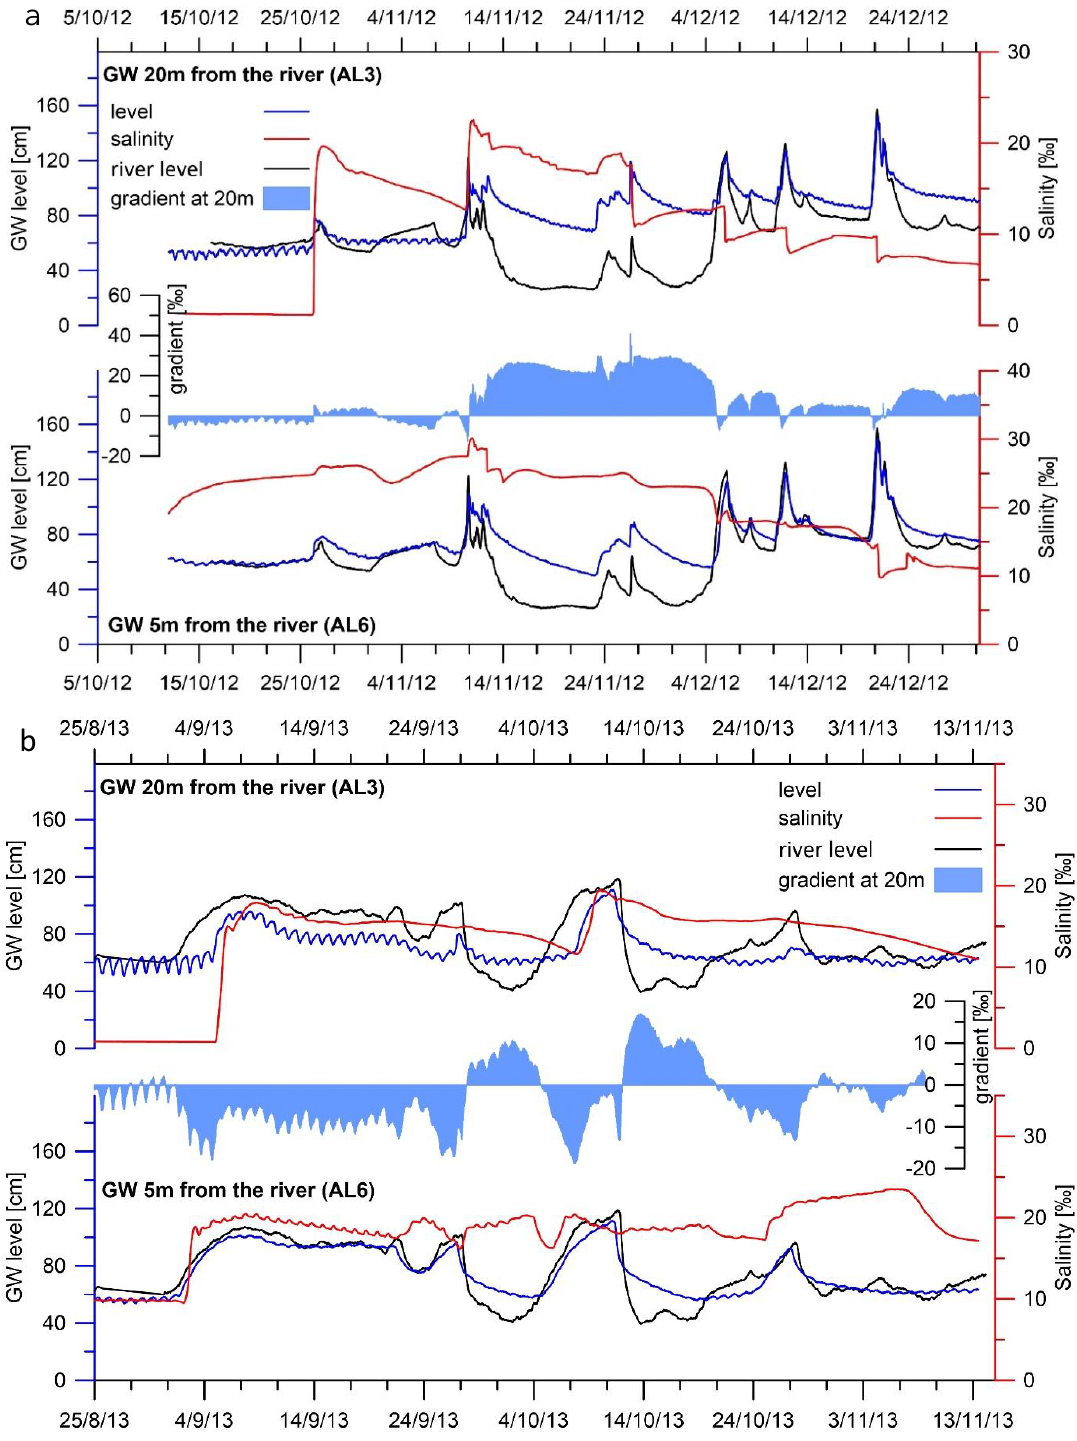
Figure 12. Groundwater level and salinity, and aquifer–river gradient during ( a ) fall 2012 and ( b ) fall 2013.